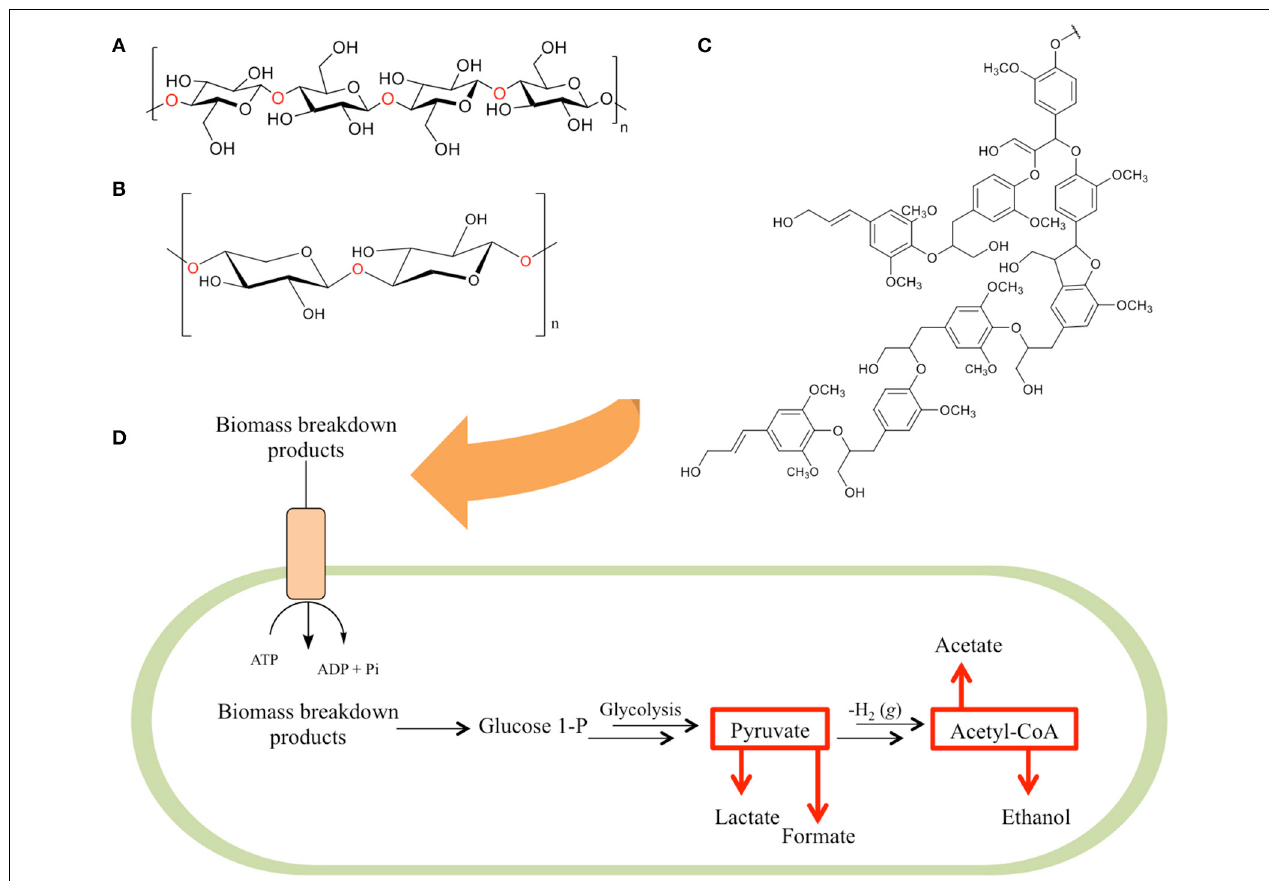
FIGURE 1 | The three primary constituents of biomass. Biomass is primarily composed of a combination of (A) cellulose—a homopolymer of glucose units, (B) hemicellulose (here depicted as xylan—a homopolymer of xylose units), and (C) lignin (here depicted as hardwood lignin)—a biopolymer composed of aromatic monomeric units. As these components are degraded